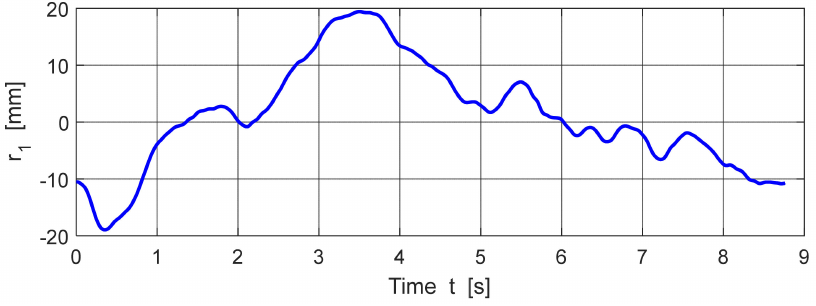
Figure 6. Vertical deflection of the center of gravity of the sprung mass of vehicle.